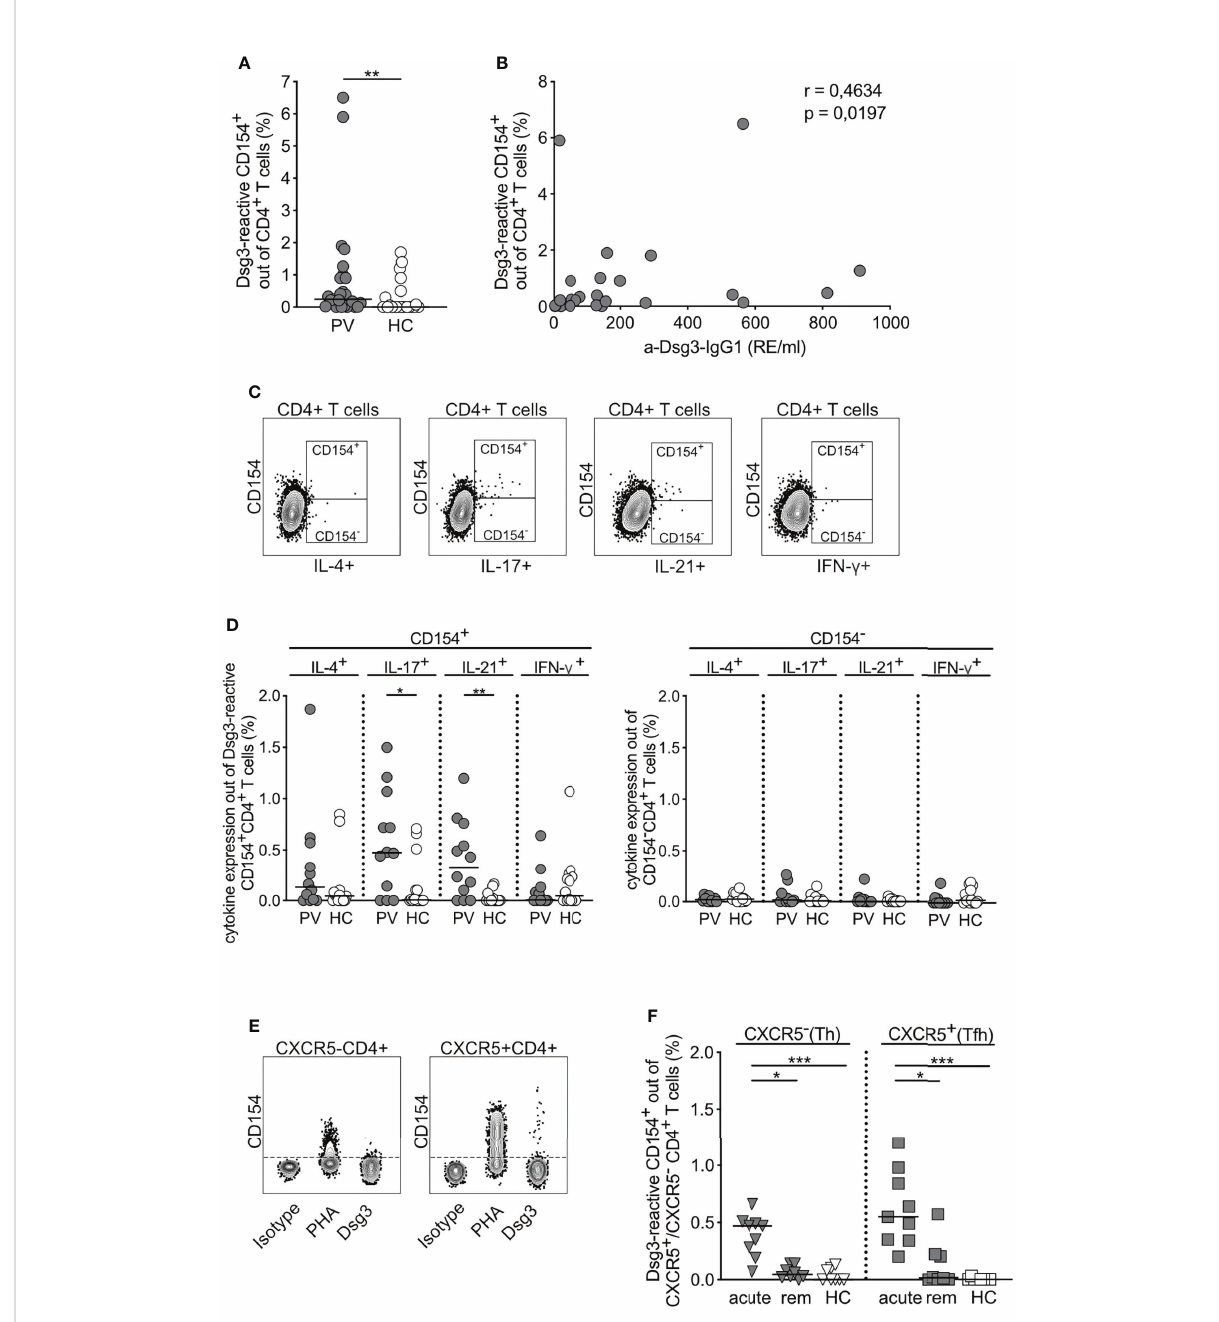
FIGURE 2 Characteristics of Dsg3-reactive CD154+ CD4+ T cells. (A) Relative frequency of CD154 expression upon ex vivo stimulation with Dsg3 in PV vs HC (PV n=25; HC n=22). (B) Correlation of anti-Dsg3-IgG1 serum concentration with relative frequencies of Dsg3-reactive CD154+CD4+ T cells in PV patients (n=25). Spearman ’ s rank correlation coef fi cient r=0.4634 and p=0.0197. (C) Representative fl ow cytometry plots depicting CD154- and CD154+ CD4+ T cells upon speci fi c Dsg3 stimulation and their respective cytokine secretion of IL-4, IL-17, IL-21 and IFN- g . (D) Relative frequency of IL-4, IL-17, IL-21 or IFN- g cytokine expression in Dsg3-reactive CD154+CD4+ T cells on the left and CD154-CD4+ T cells (right; PV n=12; HC n=14). (E) Representative fl ow cytometry plots depicting CXCR5 expression in CD4+ T cells upon respective stimulation. (F) Relative frequencies of CD154 on CXCR5-CD4+ T (Th) cells and CXCR5+CD4+ T (Tfh) cells for acute PV, remittent PV patients and HC upon speci fi c ex vivo stimulation with Dsg3 (acute PV, n=9; remittent PV, n=8; HC, n=8). (D) p<0.05 *, p<0.01 **, p<0.001